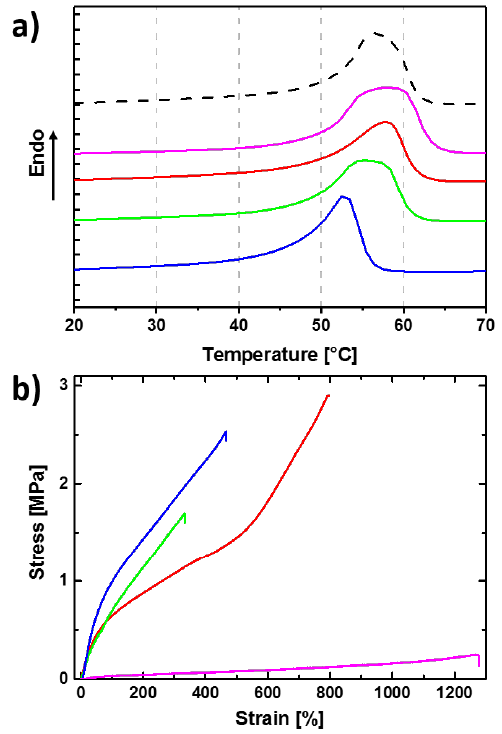
Figure 2. ( a ) Comparison of DSC thermograms for: cPCL 95 -L 05 (blue), cPCL 83 -L 17 (green), cPCL 70 -L 30 (red), cPCL 40 -L 60 (magenta), and linear PCL (dashed black line); ( b ) Comparison of the stress-strain curves obtained in tensile tests at 90 °C for different crosslinked PCL networks: cPCL 95 -L 05 (blue), cPCL 83 -L 17 (green), cPCL 70 -L 30 (red), and cPCL 40 -L 60 (magenta). Table 1. Summary of physical properties of cPCL networks.